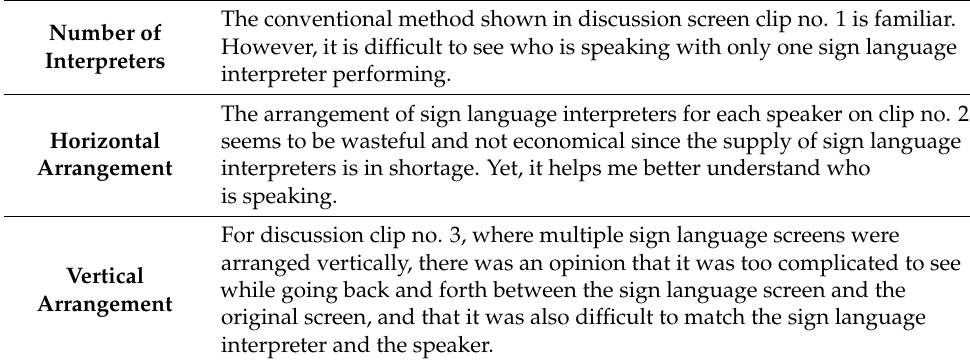
Table 7. Subjects’ opinions on the panel discussion clips.